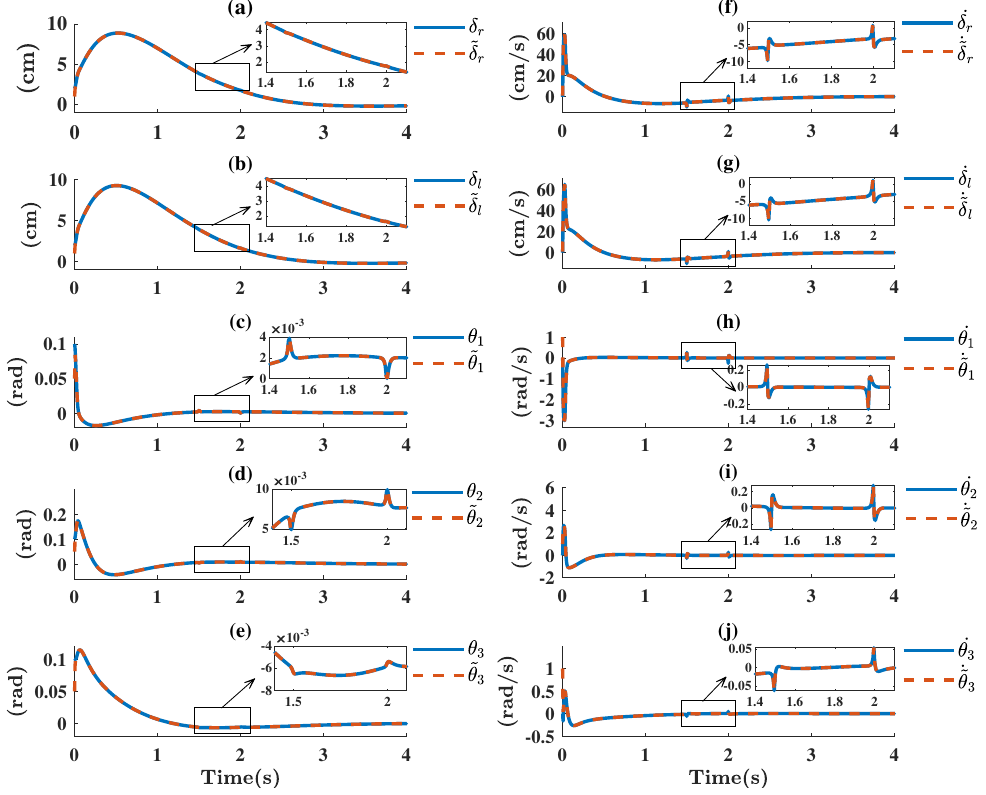
Figure 5. Response of original states vs. estimated states. ( a ) δ r vs. ˜ δ r ; ( b ) δ l vs. ˜ δ l ; ( c ) θ 1 vs. ˜ θ 1 ; ( d ) θ 2 vs. ˜ θ 2 ; ( e ) θ 3 vs. ˜ θ 3 ; ( f ) ˙ δ r vs. ˙˜ δ r ; ( g ) ˙ δ l vs. ˙˜ δ l ; ( h ) ˙ θ 1 vs. ˙˜ θ 1 ; ( i ) ˙ θ 2 vs. ˙˜ θ 2 ; and ( j ) ˙ θ 3 vs. ˙˜ θ 3